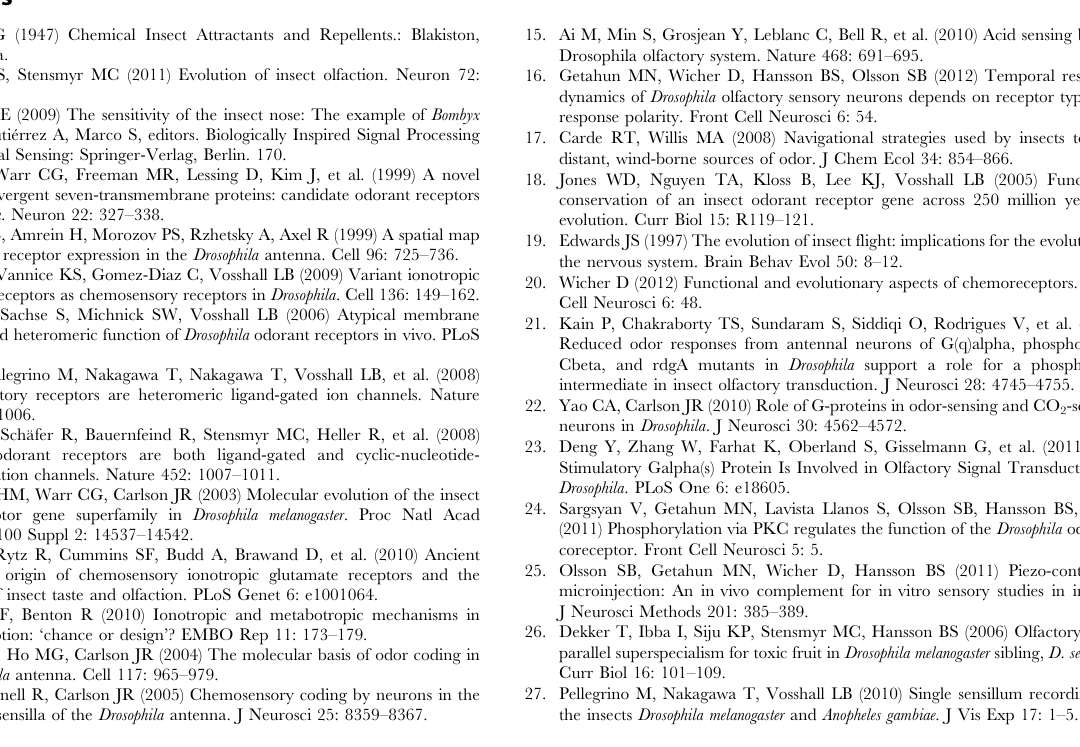
Figure S1 Effect of compound injection on spontaneous activity of OSNs. A , Recordings of spontaneous spike frequency (f norm , normalized to first 15 s of recording) for ab3A and ab3B neurons with injection of saline (Control, ab3A, n = 5) or ethyl butyrate (Etb, ab3A, ab3B, n = 11) at 100 s. B , Recordings of f norm for ab3A neurons with injection of saline (Control, n = 5) or 8-br- cAMP ( n = 12) at 100